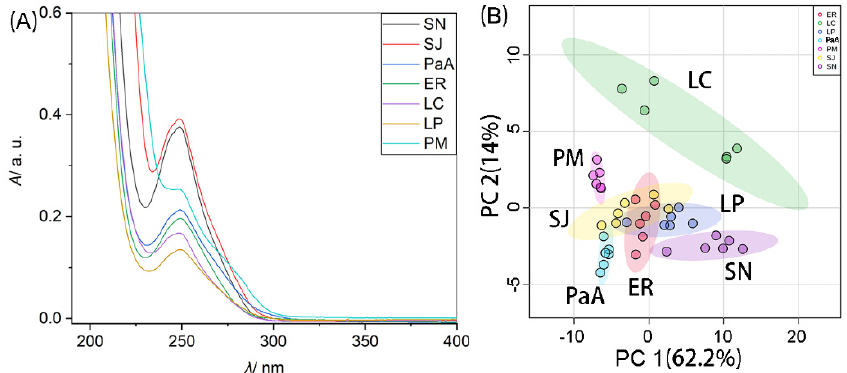
Figure 2. ( A ) UV-Vis spectra of muscle extracts of seven fish species from fish samples of Scomber japonicus (SJ), Scomberomorus niphonius (SN), Larimichthys crocea (LC), Larimichthys polyactis (LP), Epinephelus rivulatus (ER), Pampus argenteus (PaA) and Pagrosomus major (PM). ( B ) Plot of principal component analysis (PCA) scores for the UV-Vis spectra of the seven fish species. The other conditions make reference to the information listed in Table 1.